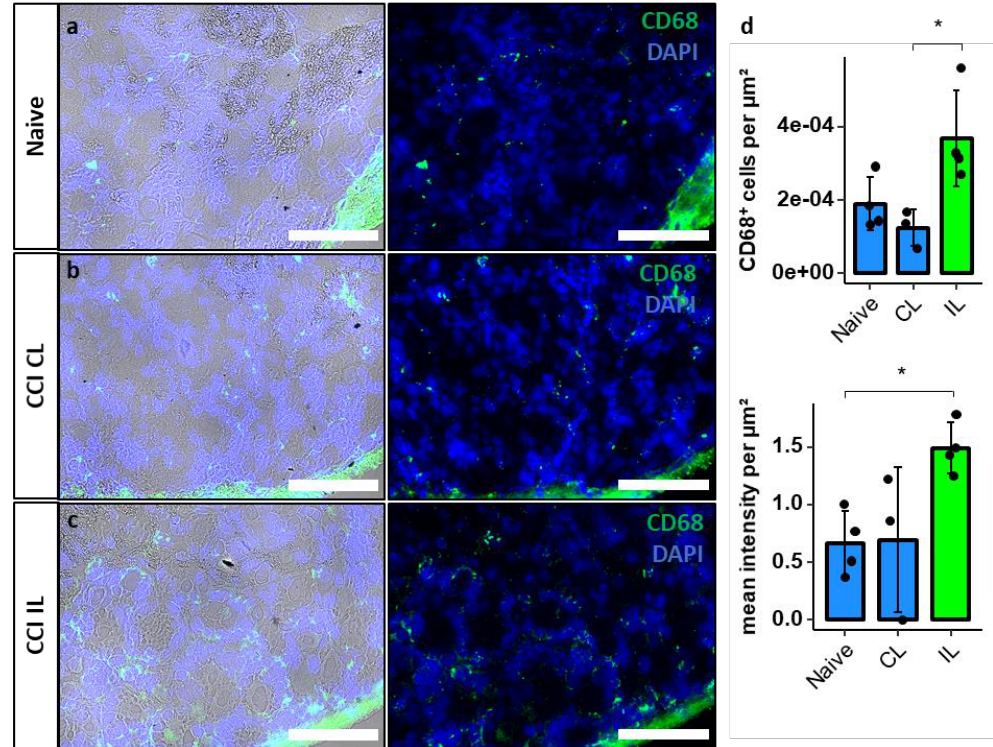
Figure 8. Increased macrophage invasion in the NRR after CCI. DRGs of naive ( a ) and contralateral (CL) ( b ) and ipsilateral (IL) ( c ) DRGs of Wistar rats 7d after CCI were harvested and stained using DAPI and anti-CD68 antibodies (left: immunofluorescence with brightfield; right: only immunofluorescence). In the NRR, CD68+ cells were counted manually, and signal intensity was measured. Both were quantified per µm² ( d ). ( n = 3 or 4; CD68+ cells per µm²: CL versus IL, p = 0.024; mean intensity per µm²: Naive versus IL, p = 0.038. Two-way ANOVA, Tukey HSD; scale bars = 100 µm; * p < 0.05.)